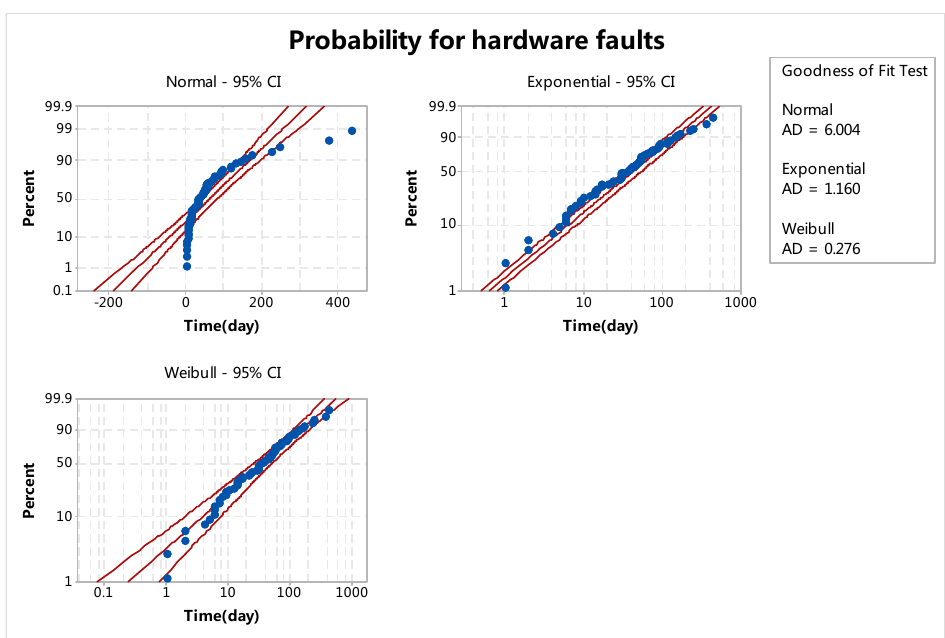
Figure 12. Goodness of fit test for software faults.